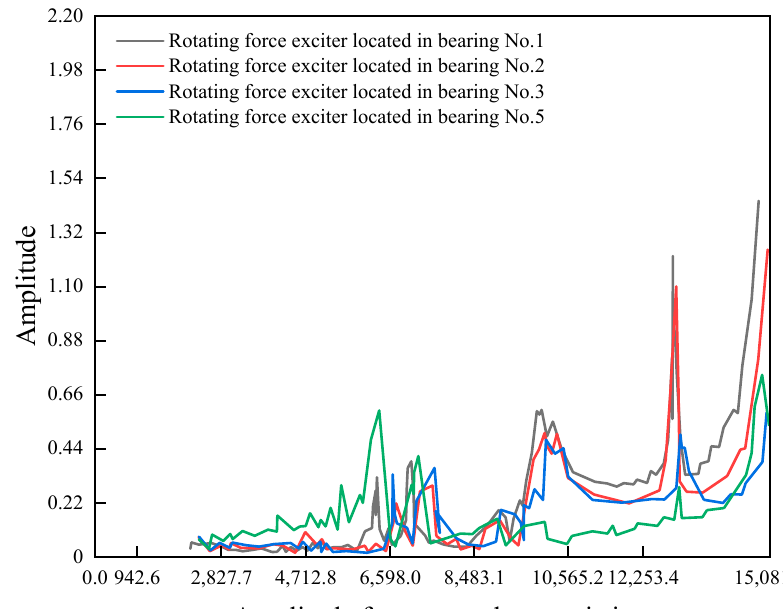
Figure 11. Vibrational transmission ratio amplitude characteristics for vertical measuring point of the combustion chamber with exciting force acted at different locations.